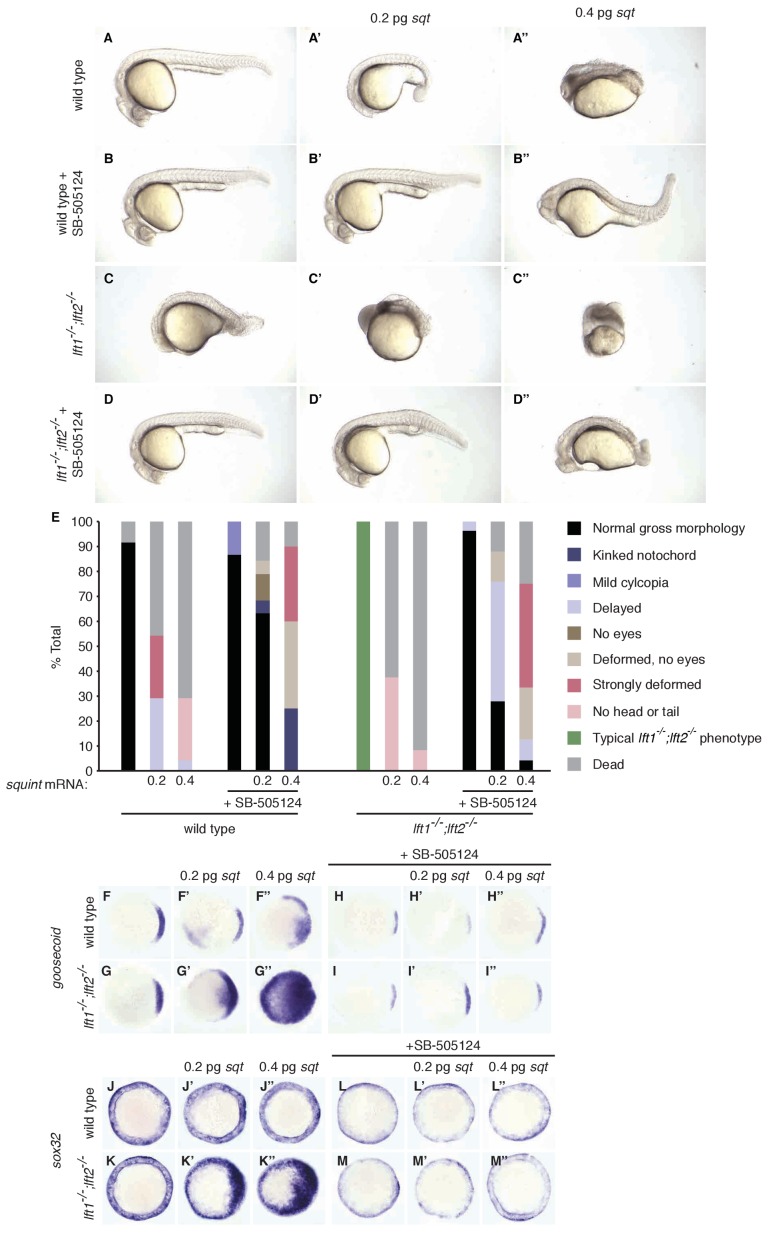
Response of wild type and lefty1-/-;lefty2-/- mutant embryos to squint injection.Wild type and lft1-/-;lft2-/- mutant embryos were injected with 0.2 or 0.4 pg sqt mRNA at the one-cell stage. Embryos were then exposed to 2.5 μM SB-505124 (Nodal inhibitor drug) starting at the 8 cell stage (see Figure 6, Figure 6—figure supplements 1, 2 and 3, and Figure 2—figure supplement 1). (A–D’’) Phenotypes at 1 day post-fertilization (dpf). Embryos injected with sqt mRNA exhibit dramatic morphological defects and frequently die by 1 dpf, whereas embryos injected with sqt mRNA and treated with Nodal inhibitor drug have more normal morphology and higher survival rates. (E) Percentages of embryos with the indicated phenotypes. Injected, drug-treated embryos have higher survival rates and more normal morphology than injected embryos that were not treated with drug. Total embryos analyzed: wild type = 24, wild type + 0.2 pg sqt = 24, wild type + 0.4 pg sqt = 24, wild type + drug = 15, wild type + 0.2 pg sqt + drug = 19, wild type + 0.4 pg sqt +drug = 20, lft1-/-;lft2-/- mutants = 24, lft1-/-;lft2-/- mutants + 0.2 pg sqt = 24, lft1-/-;lft2-/- mutants + 0.4 pg sqt = 24, lft1-/-;lft2-/- mutants + drug = 27, lft1-/-;lft2-/- mutants + 0.2 pg sqt + drug = 25, lft1-/-;lft2-/- mutants + 0.4 pg sqt + drug = 24. (F–M’’) Embryos were treated as described above, and fixed when uninjected wild type embryos reached 50% epiboly. Injection of 0.2 pg (F’) or 0.4 pg (F’’) sqt mRNA caused upregulation of the mesoderm marker goosecoid in wild type embryos. (G–G’’) Compared to wild type embryos, lft1-/-;lft2-/- mutants exhibited stronger upregulation of goosecoid upon injection of 0.2 pg (G’) or 0.4 pg (G’’) sqt mRNA. (H–I’’) Exposure to Nodal inhibitor drug decreased the size of the goosecoid expression domain (H,I). Injection of 0.2 pg (H’,I’) or 0.4 pg (H’’, I’’) sqt mRNA did not affect goosecoid expression in drug-treated wild type or mutant embryos. (J–K’’) The endoderm marker sox32/casanova was not upregulated in wild type embryos injected with 0.2 pg (J’) or 0.4 pg (J’’) sqt mRNA, but was upregulated in injected lft1-/-;lft2-/- mutant embryos (K’,K’’). (L–M’’) Exposure to Nodal inhibitor drug dampened sox32 expression in both wild type and mutant embryos (L,M). Injection of 0.2 pg (L’,M’) or 0.4 pg (L’’,M’’) sqt mRNA did not affect sox32 expression in drug-treated wild type or mutant embryos. Wild type embryos did not have a clear advantage over drug-treated lft1-/-;lft2-/- mutants in this assay.